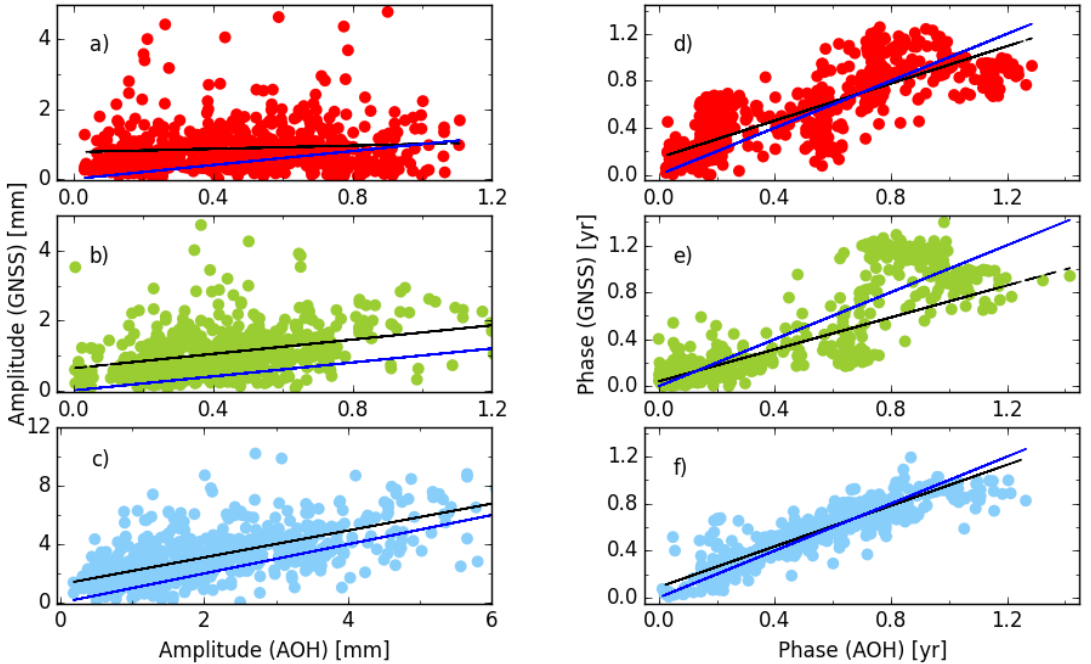
Figure 6. The agreement performance of annual signal between GNSS and AOH; ( a , d ) for east; ( b , e ) for north; ( c , f ) for vertical components. The phase is divided by 2 π and, to keep the absolute phase difference less than 0.5 year, the values out of the range from − 0.5 to 0.5 year are added one cycle and not used for fitting. The black line is the linear fitting result between GNSS and AOH and the blue line shows 1:1 perfect agreement.